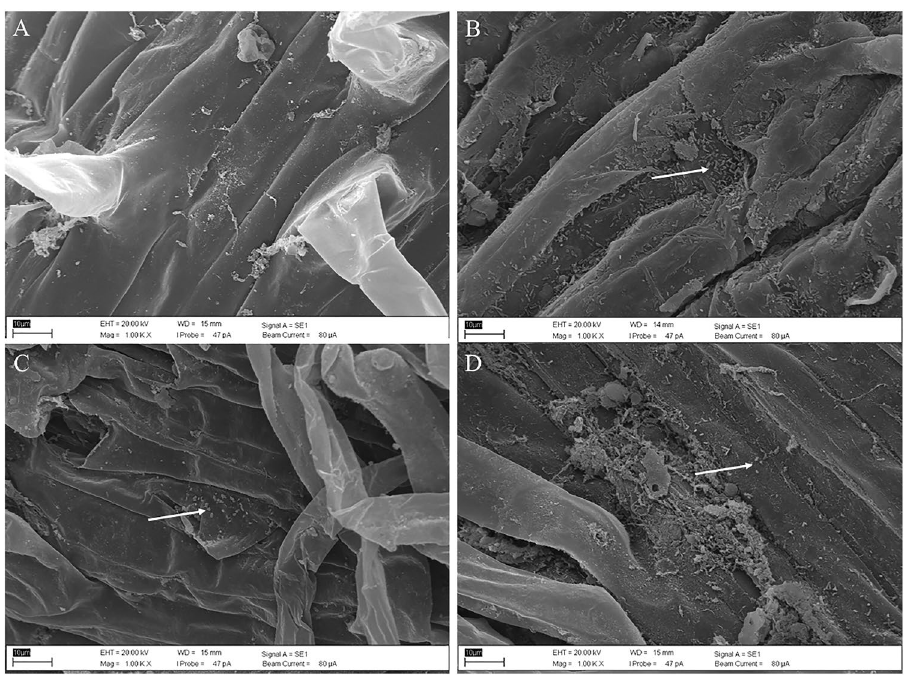
Figure 3. Scanning electron micrograph of Jerusalem artichoke roots. Clustered cells are presented by white arrowheads. ( A ) Control, ( B ) plant inoculated with B. subtilis S42, ( C ) plant inoculated with E. cloacae S81, ( D ) plant inoculated with P. azotoformans